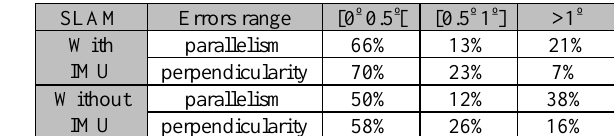
Figure 5. A top view of the generated point cloud by SLAM with IMU. The colours indicate point associations to a particular plane.